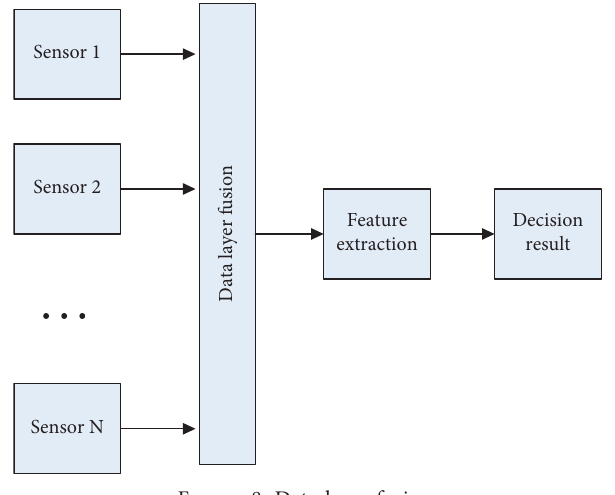
Figure 8: Data layer